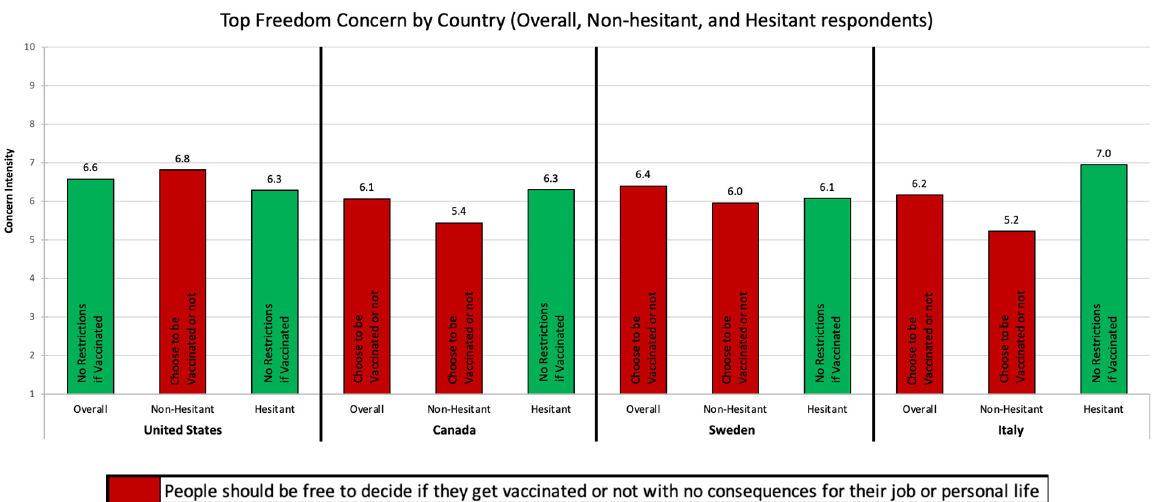
Figure 3. Top Freedom Concern by Country and Hesitancy Status.